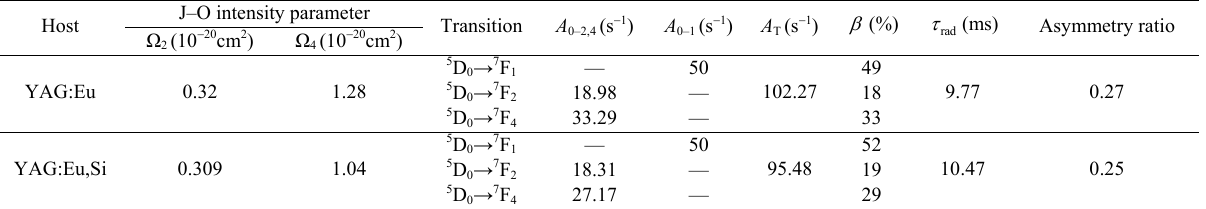
Table 3 Comparative radiative parameters and J–O intensity parameters of YAG:Eu/YAG:Eu,Si